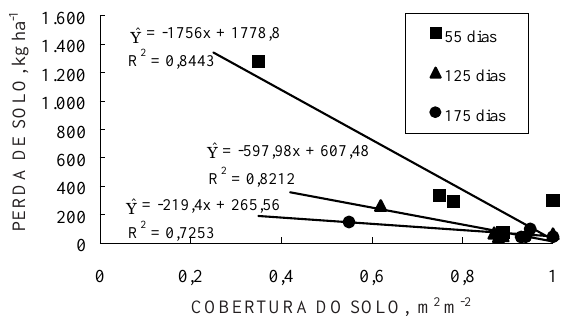
Figura 2. Relação entre a perda de solo e a cobertura do solo 55, 125 e 175 dias após o preparo do solo e